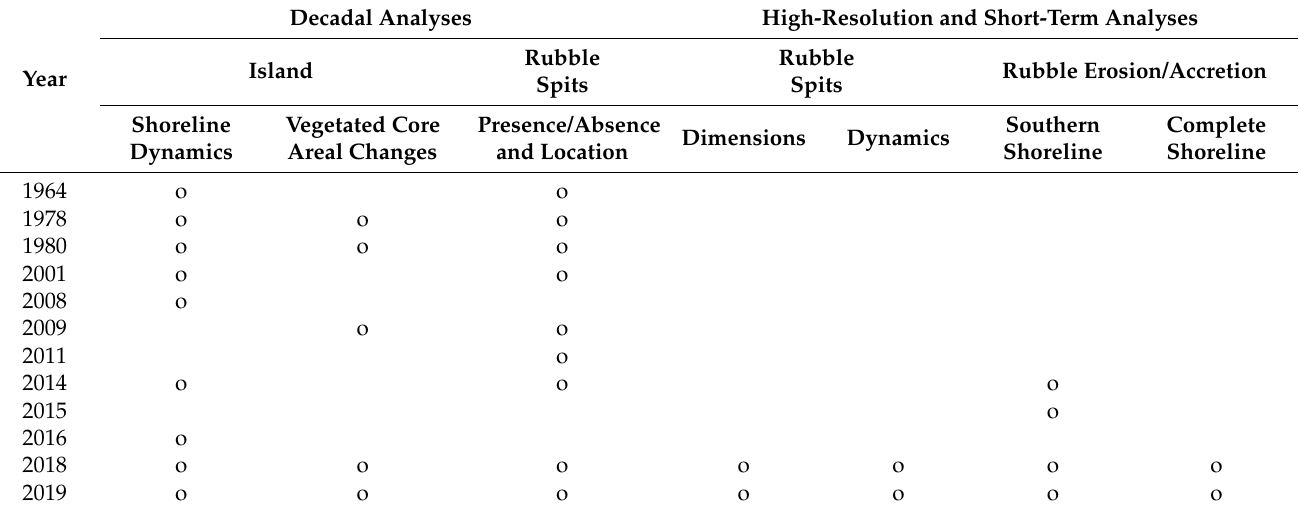
Table 3. Summary of the geomorphic change analyses performed at OTI.